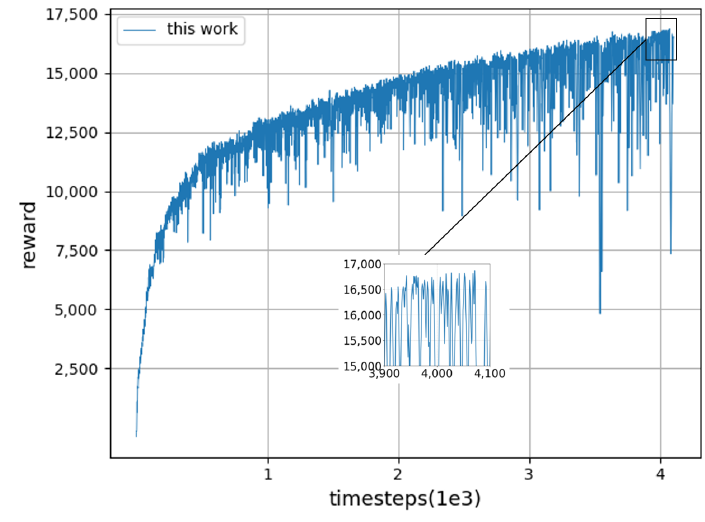
Figure 5. Training curve of constant force-tracking